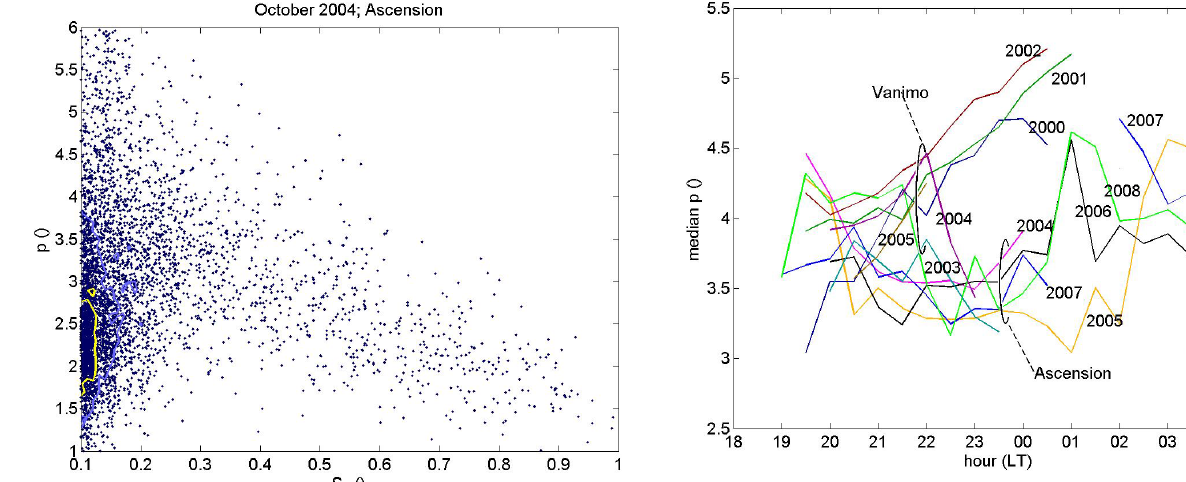
Fig. 7. Scatterplot of p and S 4 for Ascension.